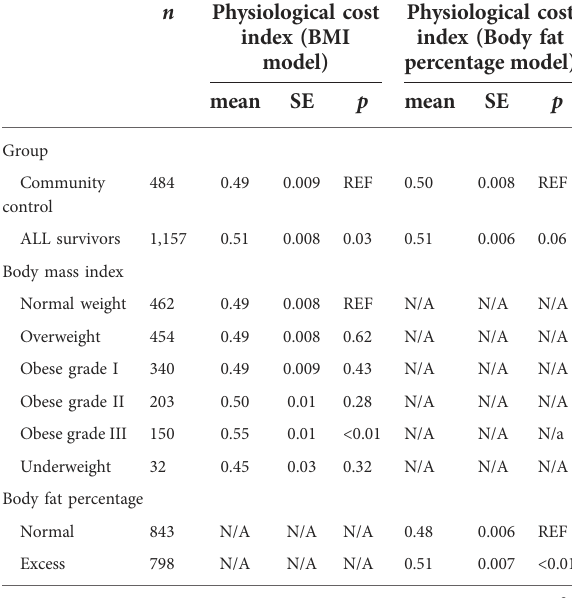
Body mass index (BMI) classi fi cations: normal weight (BMI 18.5 – 24.9 kg/m 2 ); overweight (BMI 25.0 – 29.9 kg/m 2 ); obese grade I (BMI 30.0 – 34.9 kg/m 2 ); obese II (BMI 35.0 – 39.9 kg/m 2 ); obese III (BMI ≥ 40.0 kg/m 2 ); underweight (BMI<18.5 kg/m 2 ). Normal body fat percentage (males: <27.5%; females: <39.9%); excess body fat percentage (males: ≥ 27.5%; females: ≥ 39.9%). Models were adjusted for sex, age at evaluation, physical activity, height, and smoking status. Nine survivors did not complete the six-minute walk and were removed from analysis due to uncontrolled asthma (1), paralysis (2), painful swelling in legs (2), acute neurological symptoms (1), chronic low back pain (2), and a recent triple bypass surgery (1). Seven community controls were removed from analysis due to a recently placed pacemaker (1), acute angina (1), technical error (2), severe COPD (1), unable to ambulate without assistance (1), and severe shortness of breath (1). BMI, body mass index; <, less than; n, number; N/A, not applicable; %, percent; p , probability; SE, standard error; REF,